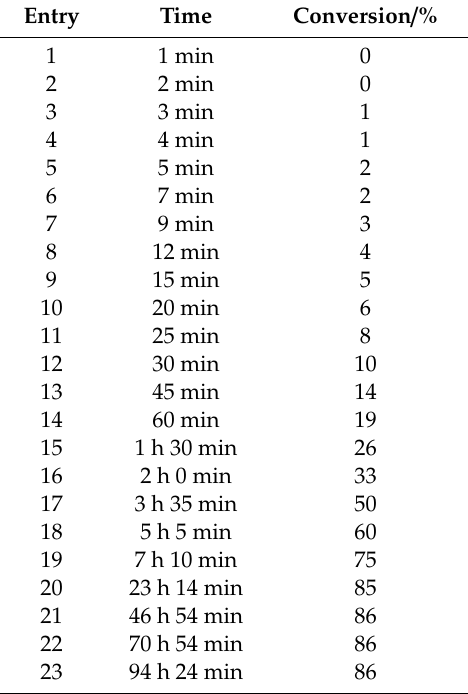
Table A3. Reduction of acetophenone ( 1 ) to 1-phenylethanol ( R )- 2 . Change from standard procedure: none.